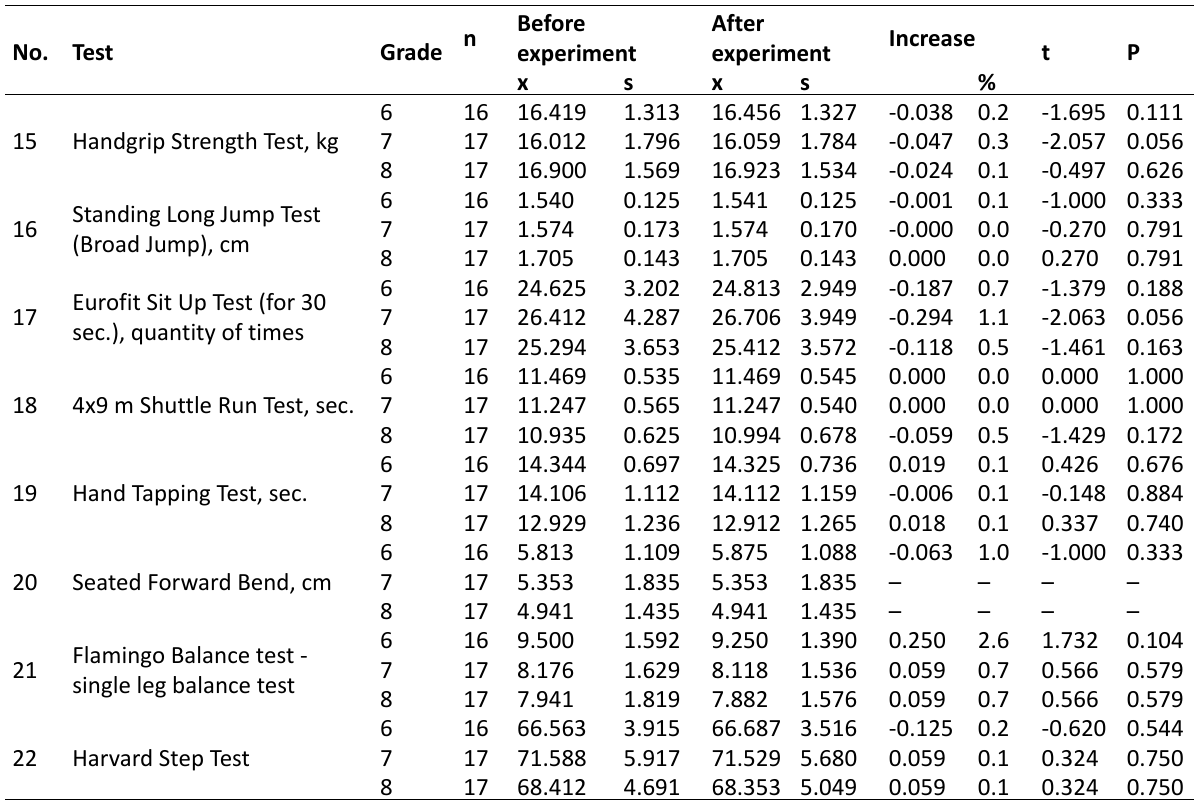
Table 5. Test results of motor fitness of the control group boys after a 4-week physical training cycle according to